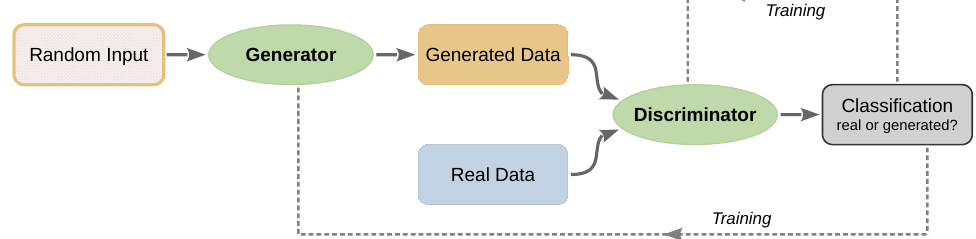
Figure 1. The architecture of a GAN model: Two adversarial networks are trained together. The generator is trained to generate new realistic data that are indistinguishable from real data, while the discriminator determines whether the data are real or